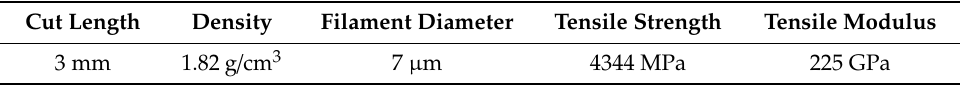
Table 3. Toho Tenax C124 carbon fibre properties.